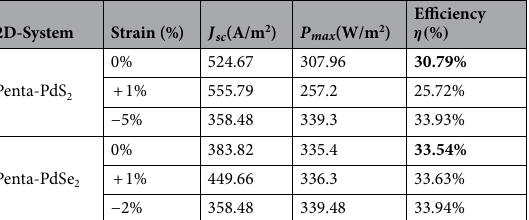
Table 3. The calculated values of J sc (A/m 2 ) , P max (W/m 2 ) and η( % ) of penta-PdQ 2 (Q = S, Se) for both pristine and loaded strain ( % ). Significant values are in bold.